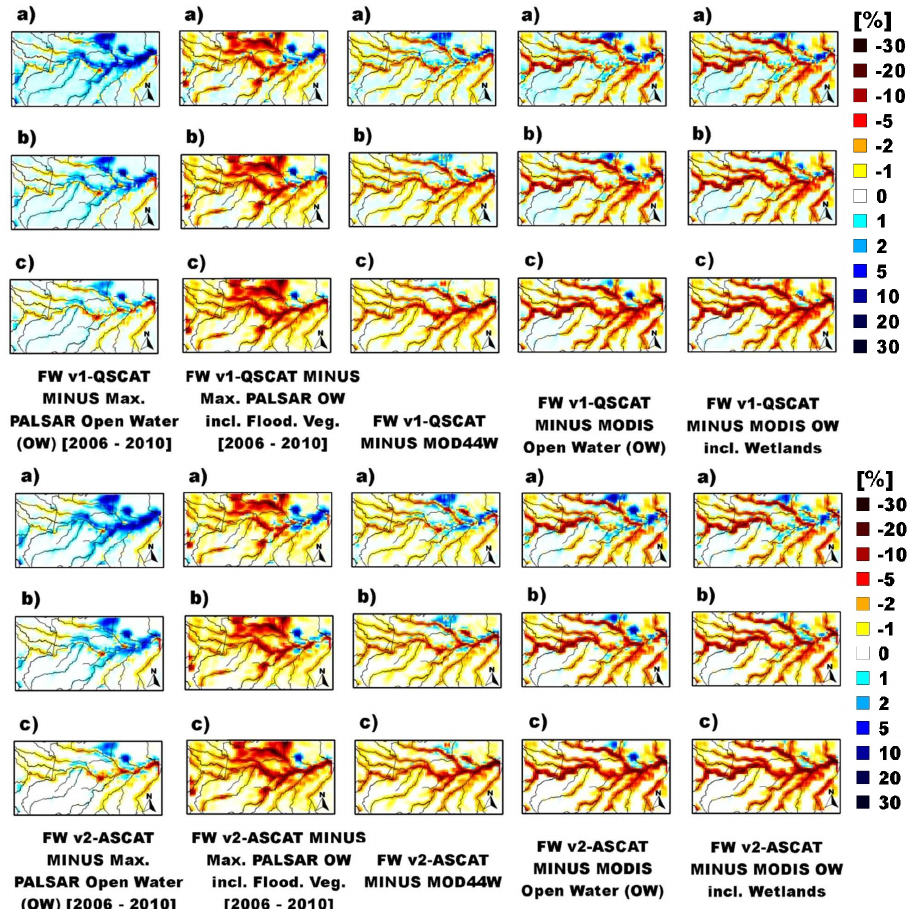
Figure 10. Difference maps between fractional water (FW) from v1-QSCAT (2000–2008) and v2-ASCAT (2009–2012) generated from ( a ) average annual maximum (FW max) , ( b ) mean (FW ave ), and ( c ) minimum (FW min ) minus open water (OW) and inundated/flooded vegetation derived from the Advanced Land Observing Satellite (ALOS) Phased Array type L-band Synthetic Aperture Radar (PALSAR) ScanSAR Amazon maximum inundation extent map and subsets of static FW from the MOD44W and MODIS including wetlands products for a section of the lower Amazon river floodplain (8.5 ˝ S–1 ˝ N, 55.5 ˝ W–74.5 ˝ W). Actual figure color is a linear interpolation of the colors in the legend. Map projection same as Figure 2. Distance covered by one degree of latitude is approximately